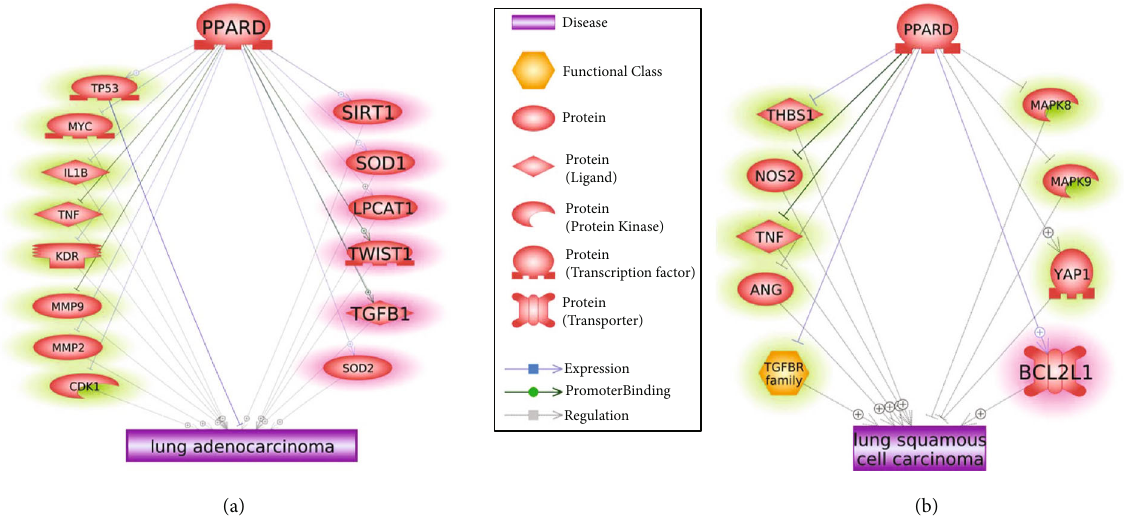
Figure 3: Pathways driven by PPARD in fl uencing the pathological development of LA and LSCC: (a) pathways connecting PPARD and LA; (b) pathways connecting PPARD and